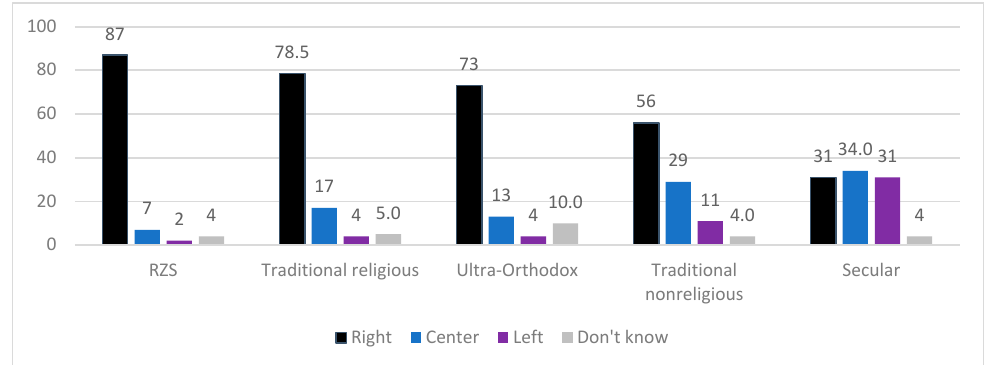
Figure 1. Political self-positioning by level of religiosity (%). (Source: Israeli Democracy Index, 2003 ‒ 2021).